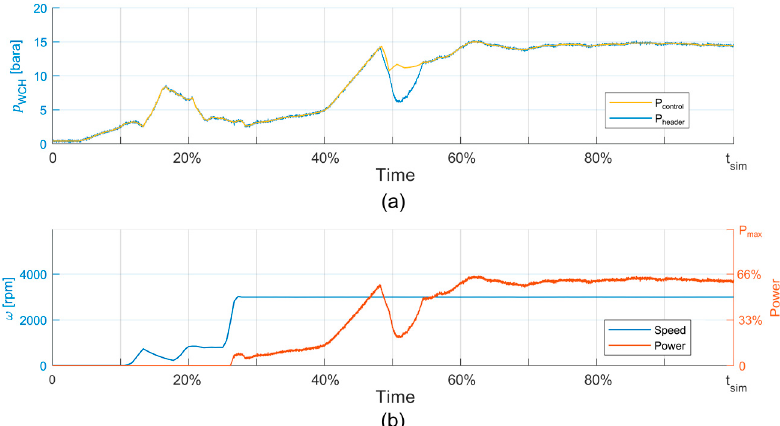
Figure 20. Example of application of NMPC to the startup of a LP turbine, steam pressure in the header, and regulated pressure in the wheel chamber ( a ), rotor speed and mechanical power of the turbine ( b